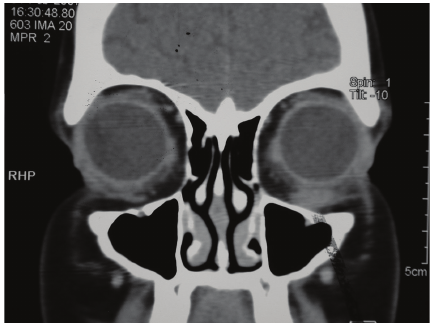
Figure 4: Histological staining with haematoxylin and eosin (10x magnification) showing multiple focally necrotising sarcoid-type granulomata.